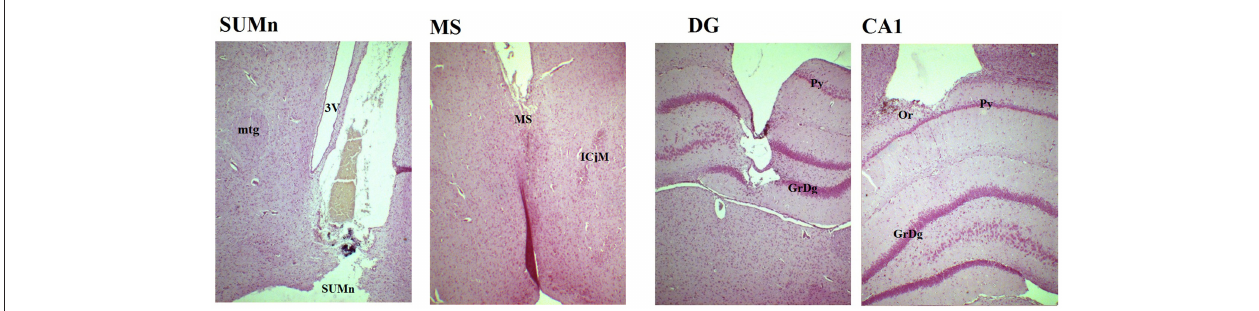
FIGURE 1 | Photomicrography of representative slices showing the position of the electrodes in the four regions. In the SUMn note that tract of the electrode reaches the zone in which the tissue was punched out for HPLC measures. SUMn, supramammillary nucleus; mtg, mamillotegmental tract; 3V, 3rd ventricle; MS, medial septum; ICjM, Major island of Calleja; DG, dentate gyrus; GrDg, granular layer of dentate gyrus; Py, pyramidal layer of CA1; CA1, field CA1 of hippocampus; Or oriens layer. Magnification 4X.